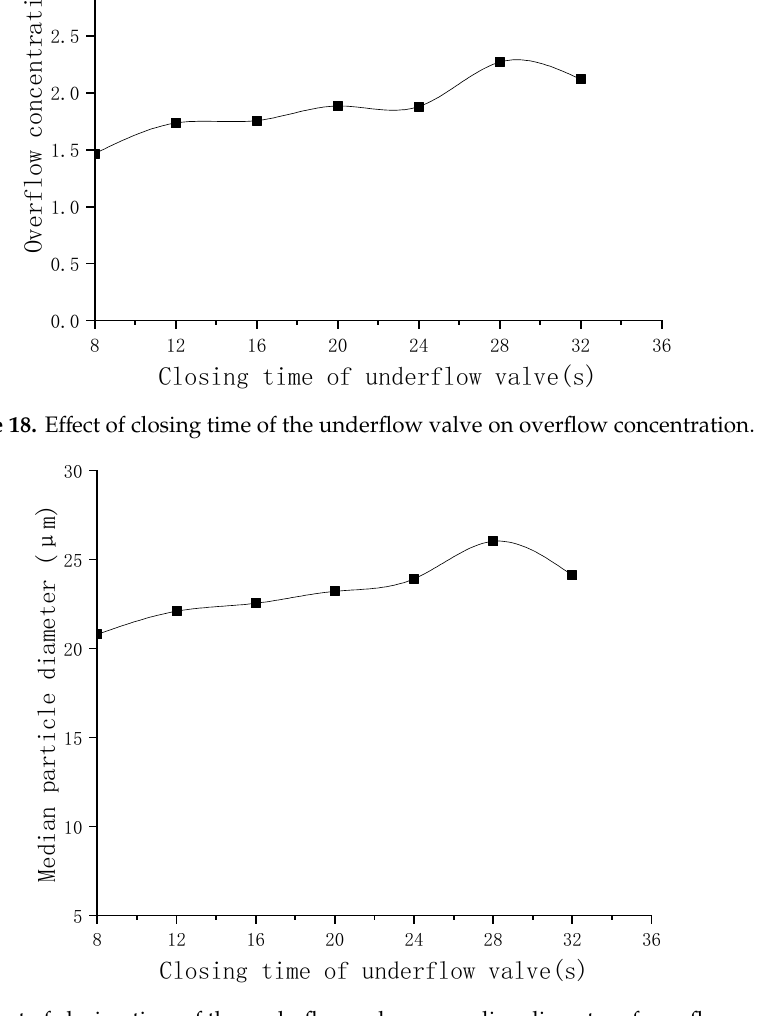
Figure 19. Effect of closing time of the underflow valve on median diameter of overflow particles.